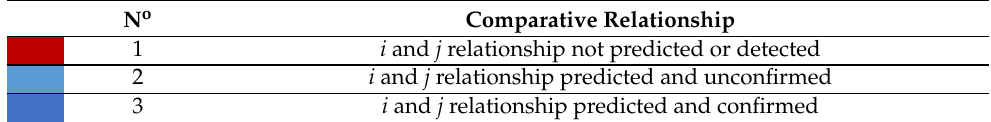
Table 2. The analyzed congruence conditions. N o Comparative